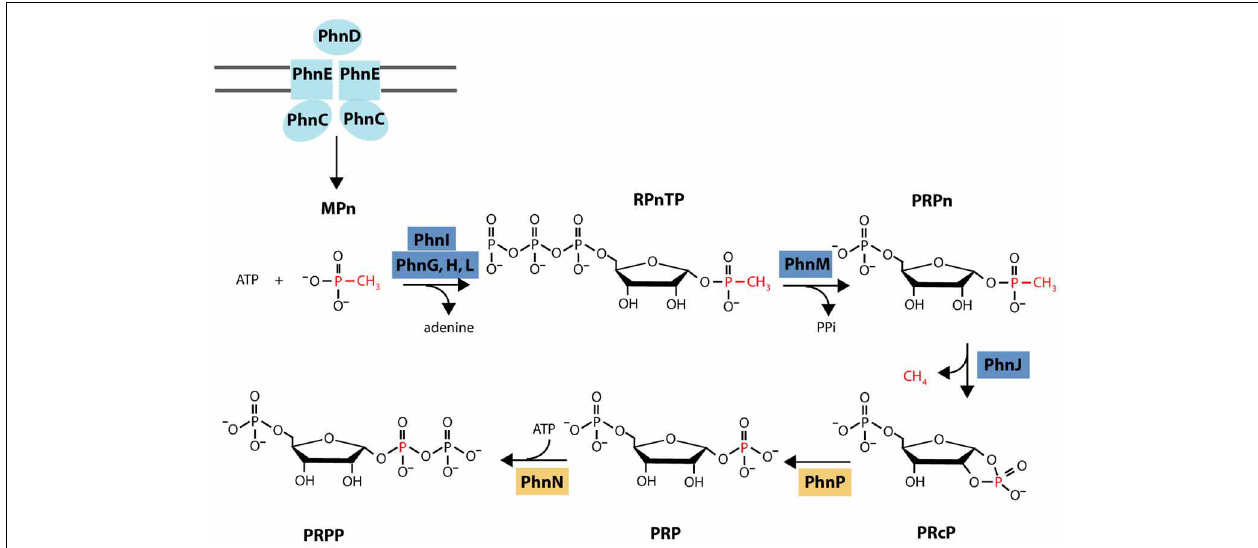
FIGURE 1 | Current biochemical model for MPn degradation. MPn is transported into the cytoplasm by the Pn-specific ABC transporter system integrated by PhnC, PhnD, and PhnE. In the cytoplasm, PhnI catalyzes the conversion of MPn and ATP to α -D-ribose-1- methylphosphonate-5-triphosphate (RPnTP) and adenine in the presence of PhnG, H, and L. PhnM is a phosphatase that hydrolyzes RPnTP to form 5-phospho-a-D-ribosyl 1-alkylphosphonate (PRPn) which is the